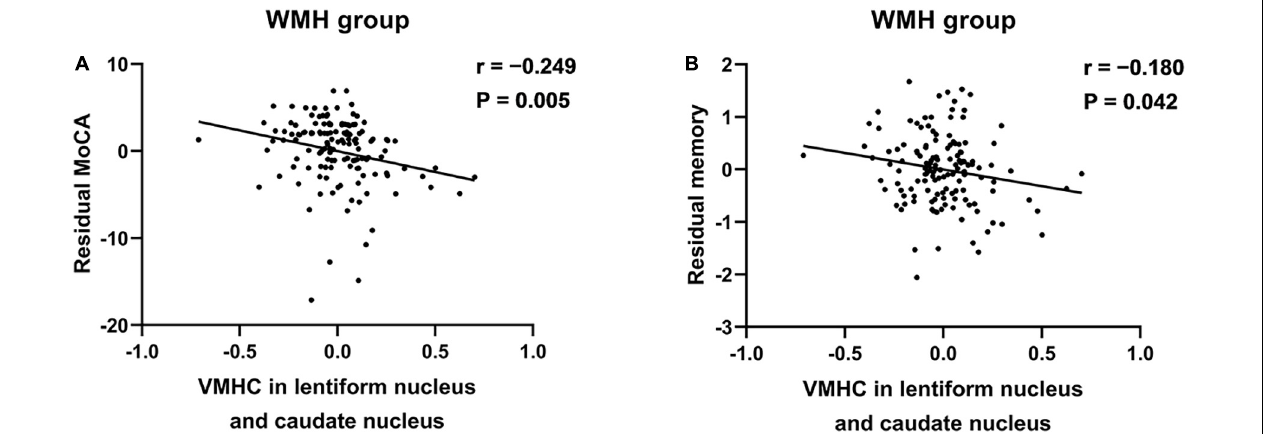
FIGURE 2 | The association between the VMHC in the LNCN and cognitive function in WMH subjects. (A) The VMHC was negatively associated with the MoCA scores. (B) The VMHC was negatively associated with the memory function. The significance level for correlation analyses was set at P < 0.05. Partial correlation analyses were conducted between the residuals of variables after regression on the nuisance variables. LNCN, lentiform nucleus and caudate nucleus; MoCA, Montreal cognitive assessment; VMHC, voxel-mirrored homotopic connectivity; WMH, white matter hyperintensity.